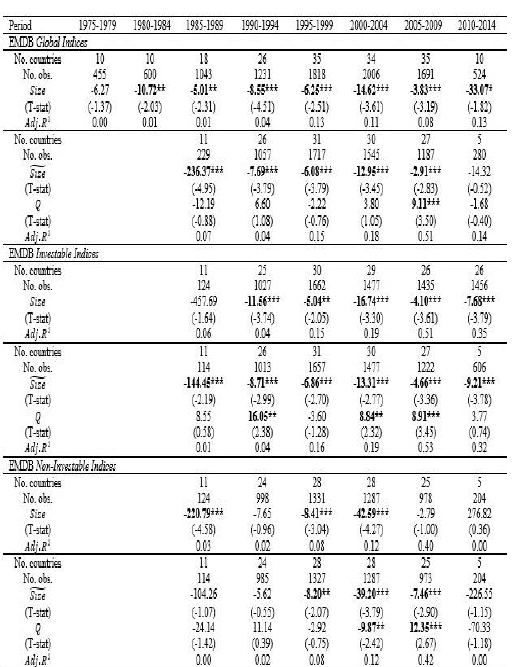
Table 8: Size Effects, Panel Data Regressions, 5-year